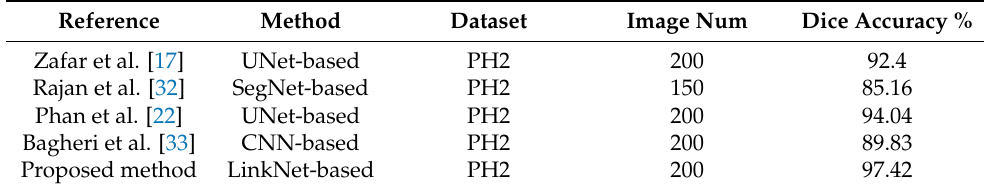
Table 6. Comparison of methods in the lesion segmentation phase with the PH2 dataset.